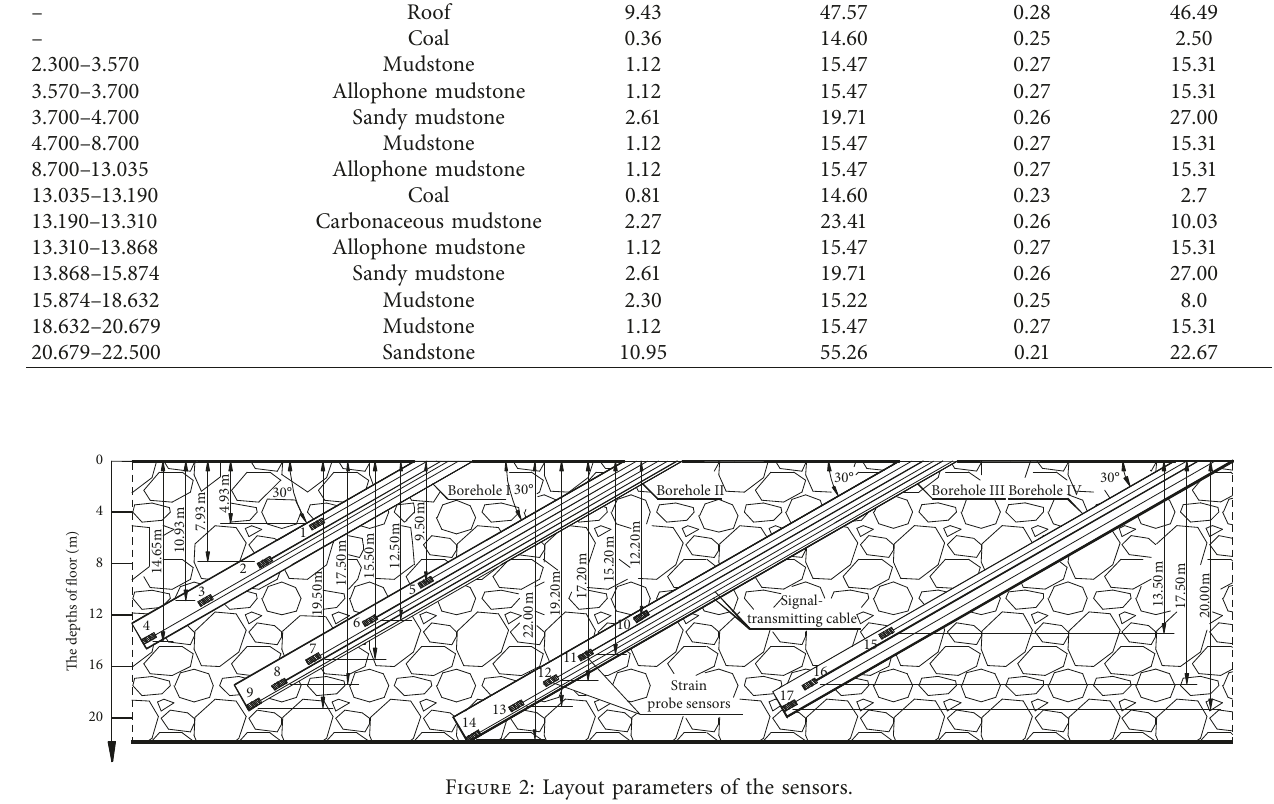
Figure 2: Layout parameters of the sensors.